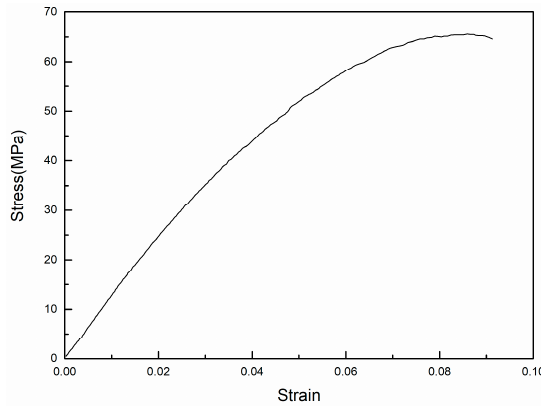
Figure 4. Tensile stress–strain curves of printed PEEK.